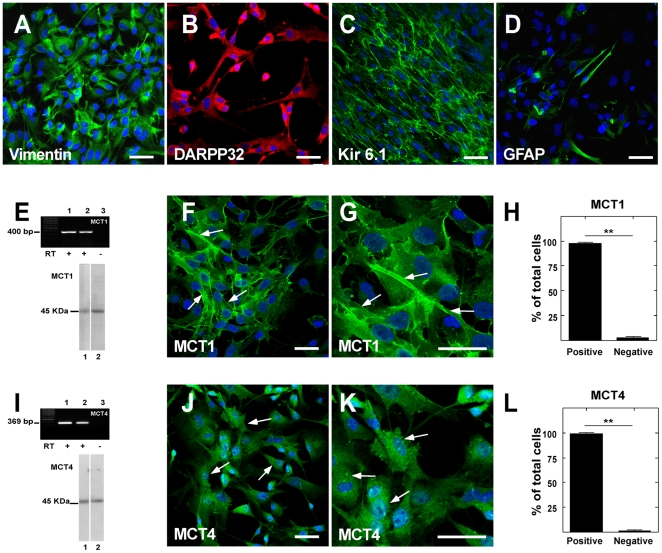
MCT1 and MCT4 expression in tanycyte cultures.
A–D, Tanycyte cultures showed high expression of vimentin, DARPP-32, and Kir 6.1 and a small number of GFAP-positive cells. E, MCT1 RT-PCR (upper panel) and immunoblot (lower panel) analyses. RNA isolated from renal cortex (lane 1) and tanycyte cultures (lane 2). RT(-) of tanycyte culture (lane 3). Total protein extracted from renal cortex (lane 1) and tanycyte cultures (lane 2). F–G, Immunohistochemical studies using anti-MCT1 antibodies (green) and TOPRO nuclear stain (blue). H, Average MCT1-positive cells. I, MCT4 RT-PCR (upper panel) and immunoblot (lower panel) analyses. RNA isolated from skeletal muscle (lane 1) and tanycyte cultures (lane 2). Total protein extracted from skeletal muscle (lane 1) and tanycyte cultures (lane 2). J–K, MCT4 immunohistochemical studies using anti-MCT4 antibodies (green) and TOPRO nuclear stain (blue). L, Average of MCT4-positive cells. Scale bar: 25 µm.